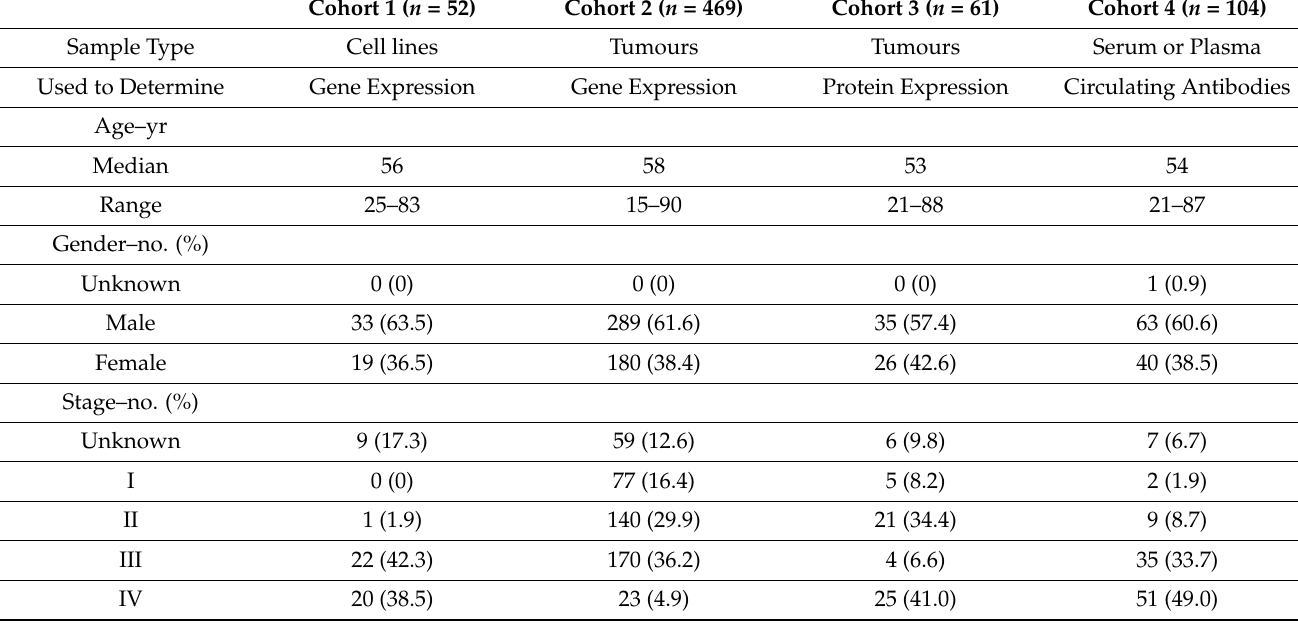
serum or plasma. Gene Expression Omnibus, GEO; TCGA, The Cancer Genome Atlas; TMAs, tissue microarrays; yr,